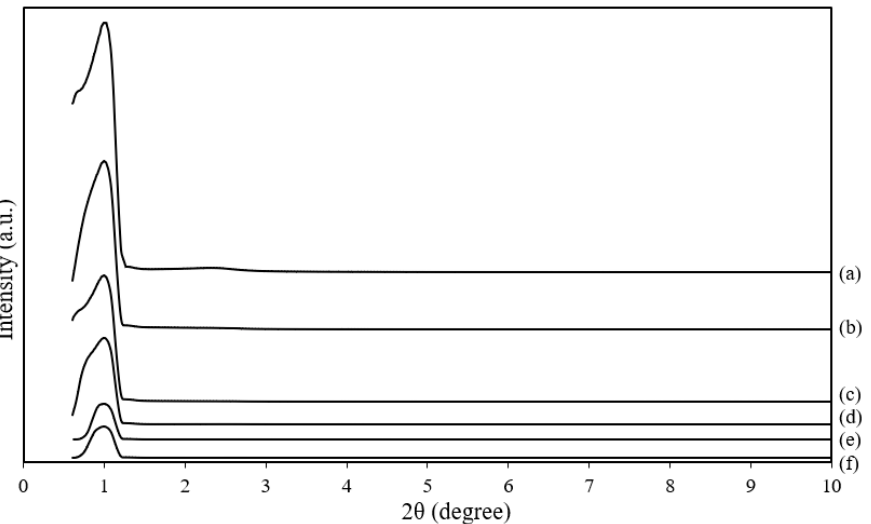
Figure 3. XRD diffraction patterns of ( a ) unfunctionalized MSU-2 and MSU-2 functionalized with TEPA loadings of ( b ) 20 wt%, ( c ) 30 wt%, ( d ) 40 wt%, ( e ) 50 wt%, and ( f ) 60 wt%.